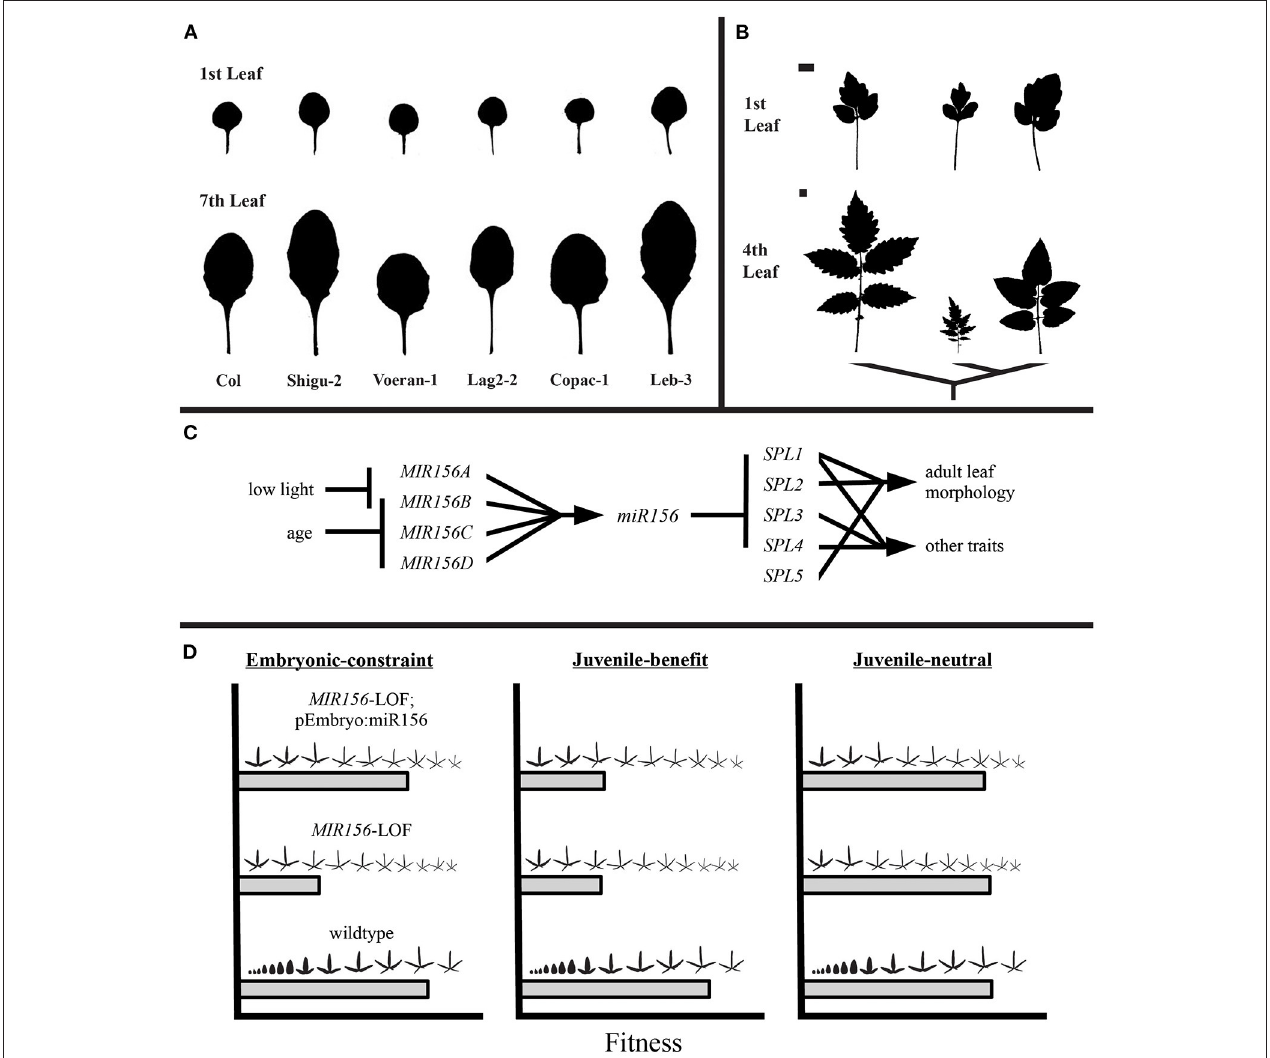
FIGURE 1 | Is there developmental constraint on early leaf morphology? In many clades, the morphology of leaves produced early in the plant life cycle are conserved between species [ (A,B) , top rows within a panel] relative to leaves produced later [ (A,B) , bottom rows within a panel]. As the GRN for many aspects of leaf morphogenesis and vegetative transitions are now known, it is theoretically possible to test how development and evolutionary forces such as selection may explain these macroevolutionary patterns. (A) Leaves are from Arabidopsis thaliana accessions. Adapted from He (2017). (B) Leaves from three tomato species. Adapted from Chitwood et al. (2012). Scale bars represent 1cm and apply for leaves within each row. (C) The miR156-SPL pathway in a hypothetical species. (D) Predicted outcomes for experimental manipulation of juvenile leaf production and tests of fitness consequences in a hypothetical species. If the need for high levels of miR156 in the embryo ensures that SPL-mediated morphologies cannot be produced early in development, then the fitness of MIR156 loss-of-function mutants ( MIR156 -LOF) should be rescued by embryo-specific expression of miR156 (left panel). Alternatively, if the phylogenetic conservation of juvenile leaves is due to a common adaptive function across species, then MIR156 -LOF mutants would be expected to exhibit reduced fitness (middle panel). Conversely, selection on juvenile leaf morphology may be weak or absent, thereby creating minimal patterns of divergence between species (right panel). Leaf heteroblastic series adapted from Chitwood and Otoni